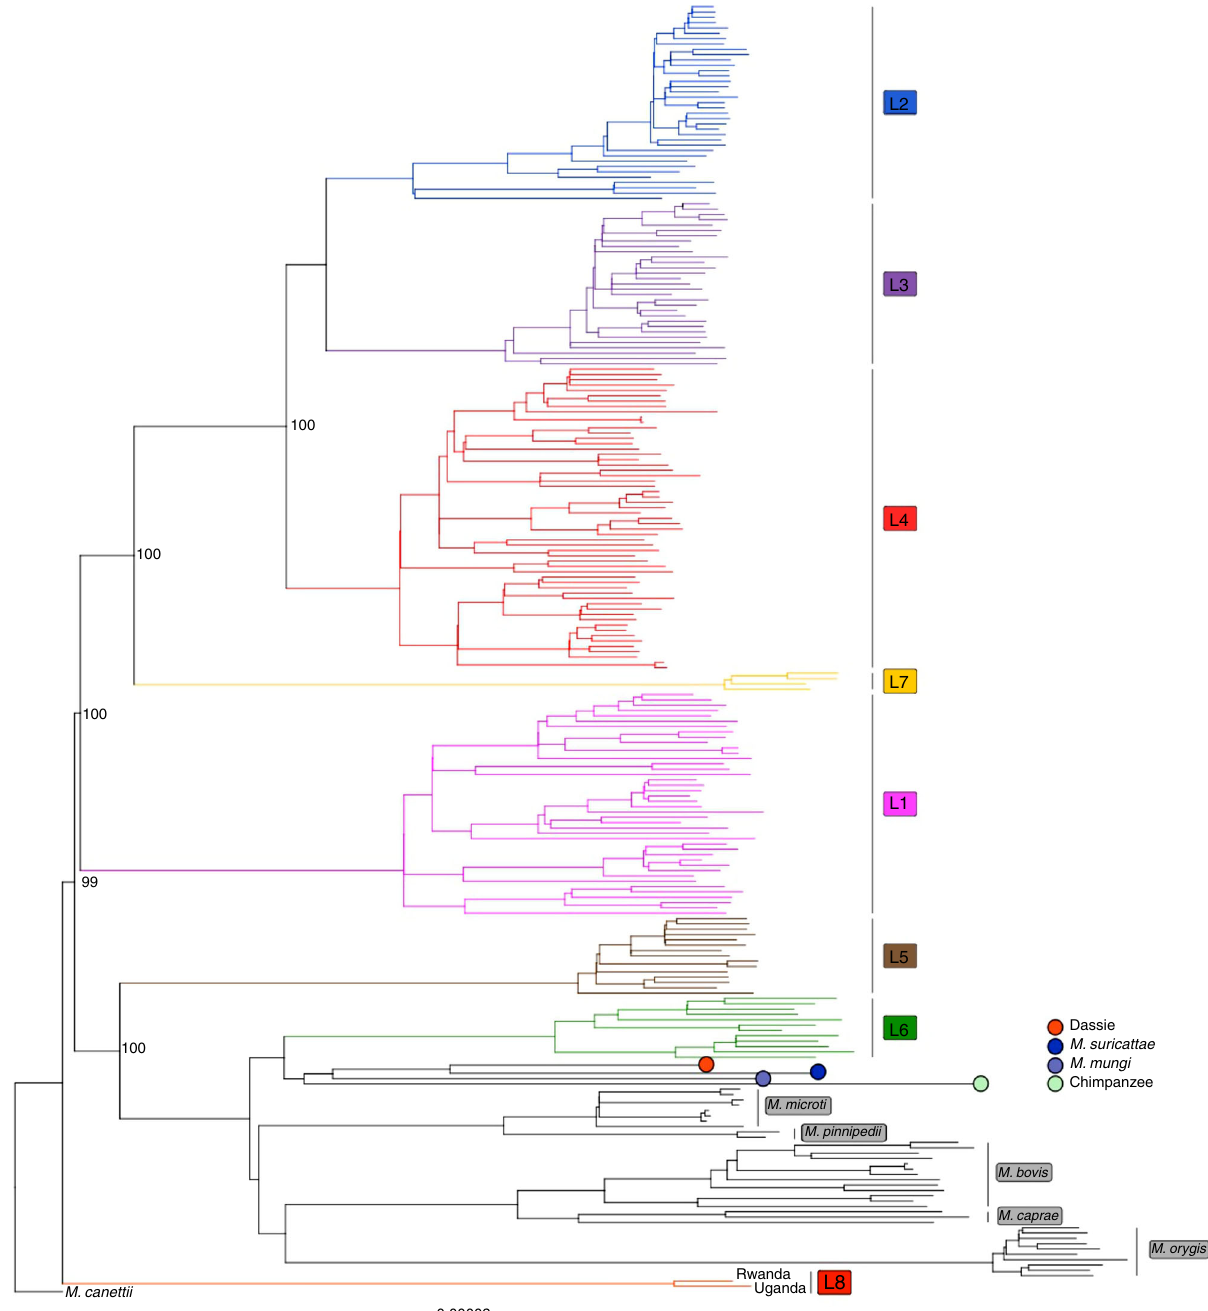
Fig. 3 Maximum likelihood phylogeny of 241 MTBC genomes, inferred from 43,442 variable positions. The scale bar indicates the number of substitutions per polymorphic site. Branches corresponding to human-adapted strains are coloured and branches corresponding to animal-adapted strains are depicted in black. The phylogeny is rooted on M. canettii and bootstrap values are shown for the most important